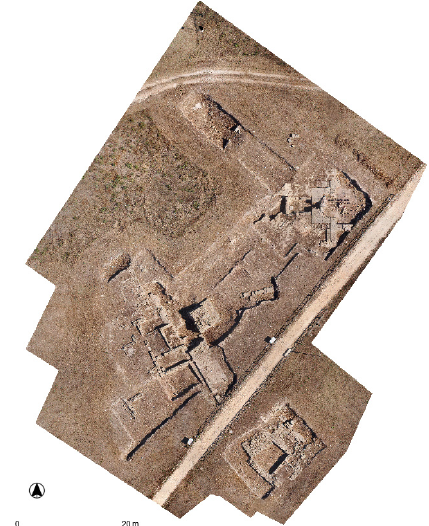
Figure 17. Ortho-image of the area of north-western fortifications and thermal